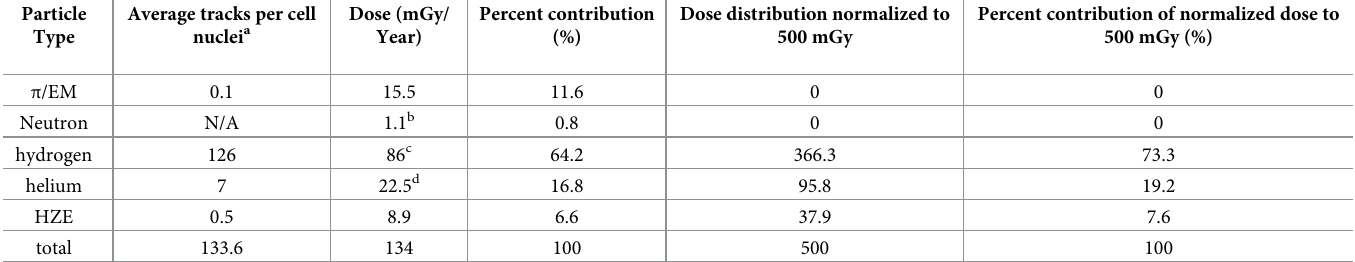
Table 2. Average tracks per cell nucleus per year, dose (mGy/year), and percent contribution of particles to dose for reference field during 1-year solar minimum and normalized to 500 mGy. Particle